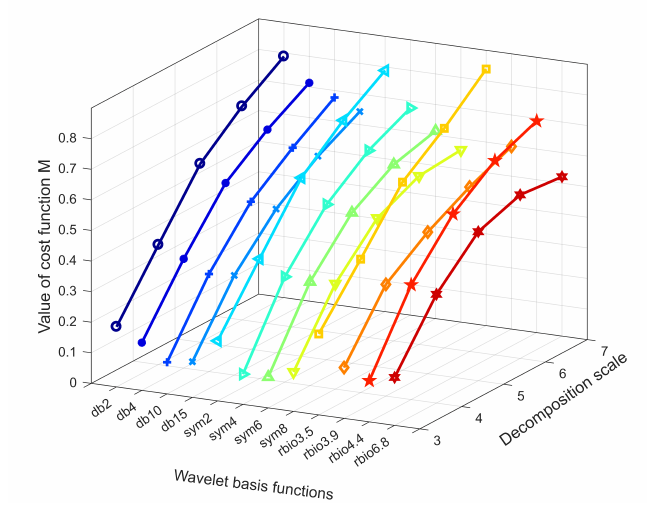
Figure 9. Value curves of the cost function M vs wavelet basis functions and decomposition